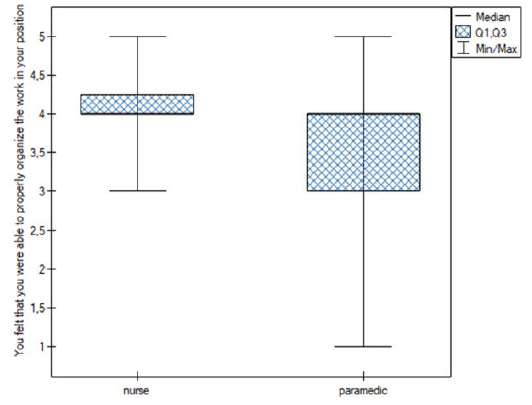
Figure 1. Work organization.